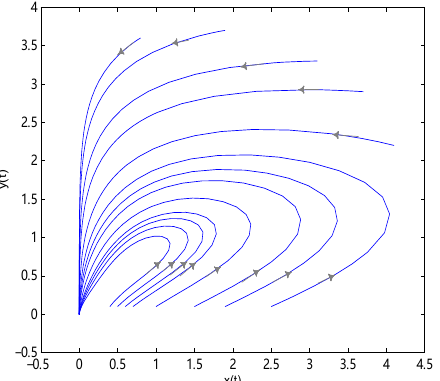
Figure 14. O is globally asymptotically stable. A 4 (0.5, 0.5) is a degenerate critical point. In here r = 1.5, ω = 1, b = 0.5, c = 1, α = 0.5.